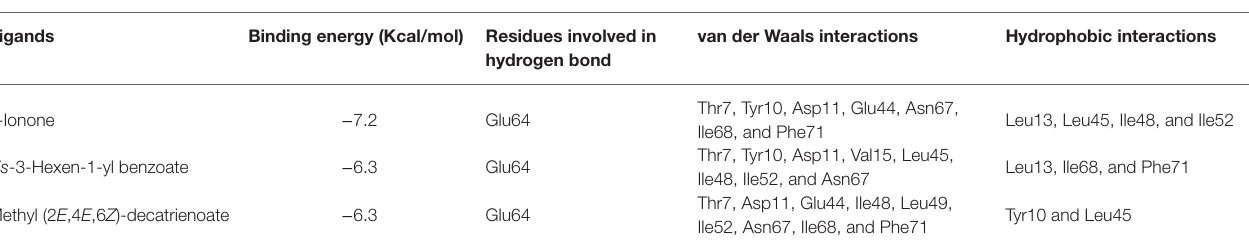
TABLE 2 | Docking results for HhalCSP15 with different